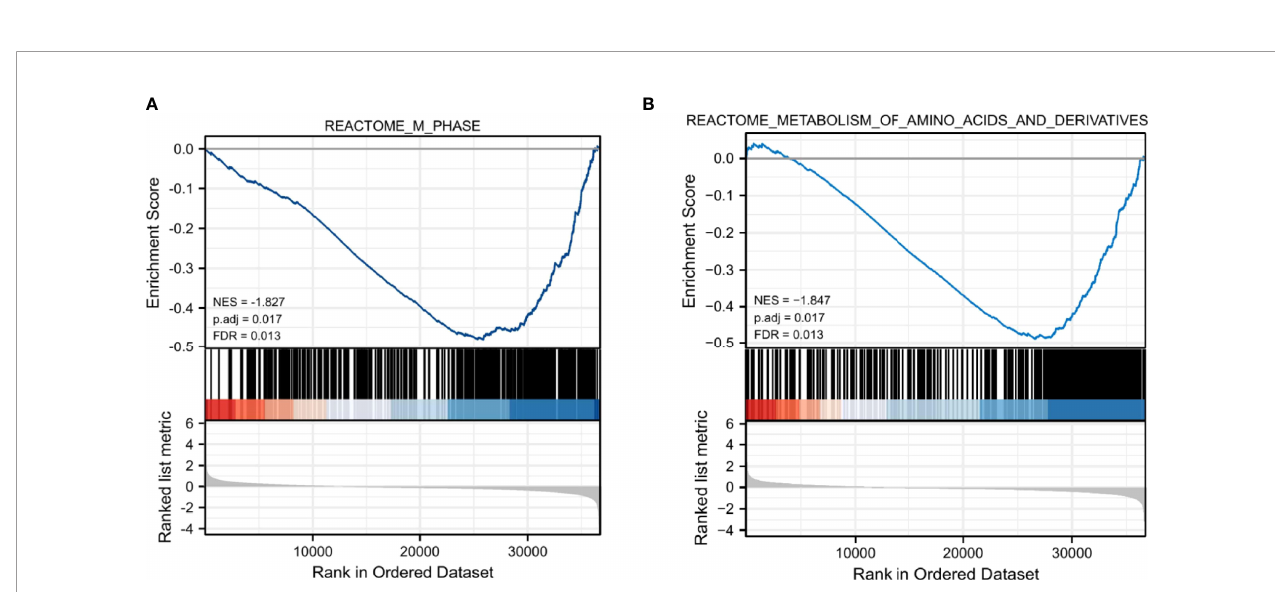
FIGURE 7 | GSEA revealed that M phase (A) and metabolism of amino acids and derivatives (B) were enriched in the low CRIM1 expression group. NES, normalized ES; FDR, false discovery